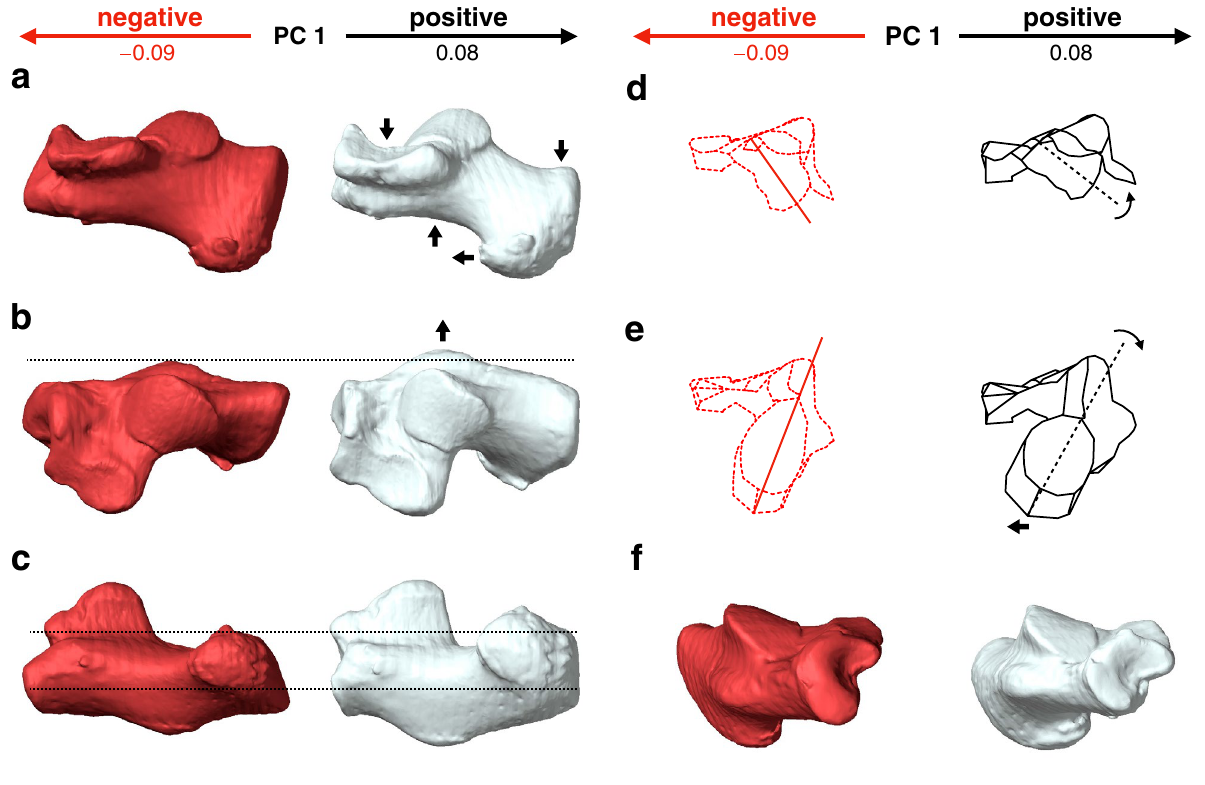
Figure 7. Shape variations represented by PC1 in the ape-only analysis. Shape variations are visualized using the wireframe connecting primary landmarks and the template surface deformed using a thin-plate spline function. Black line and white surface: PC1 = 0.08. Red line and red surface: PC1 = − 0.09. Black arrows indicate characteristics of the positive score. The medial ( a ), superior ( b ), inferior ( c ), posterior views of anterior ( d ) and posterior ( e ) parts, and anterolateral ( f ) views were